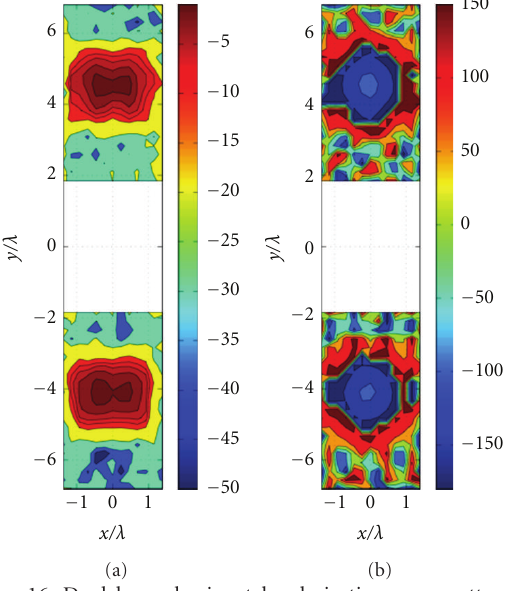
Figure 16: Dual horn, horizontal polarization, sum pattern. (a) amplitude of the aperture field distribution. (b) phase of the aperture field